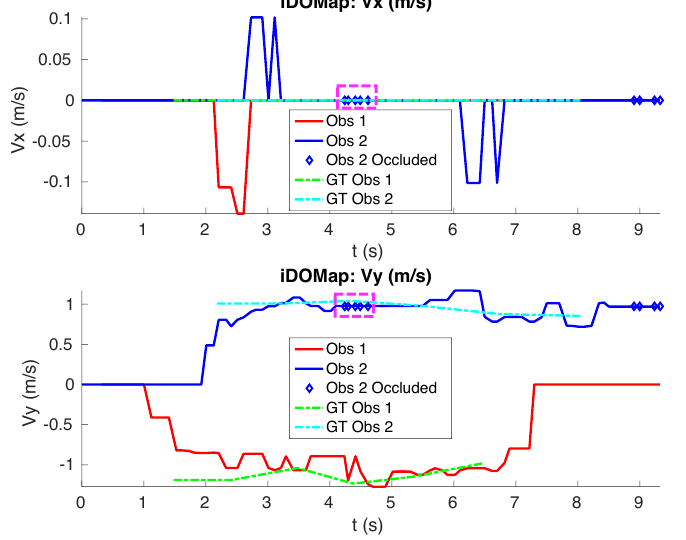
Figure 13. Real scenario 1—Detected